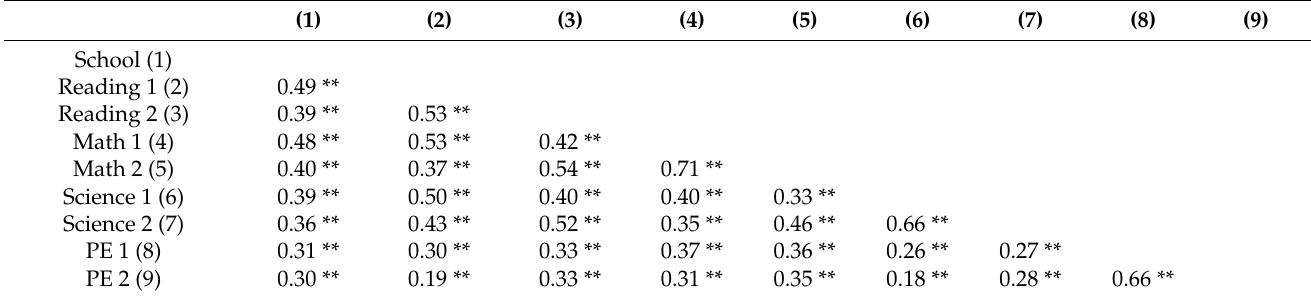
Table 4. Bivariate correlations for group as